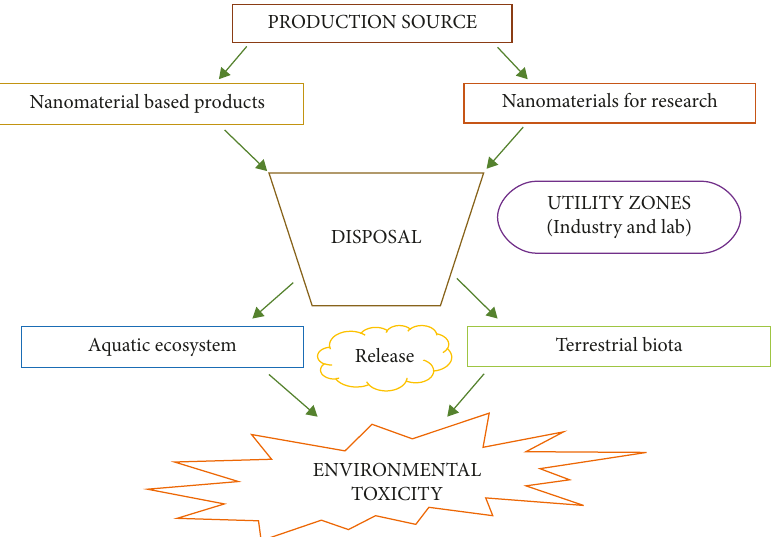
Figure 1: Sourced of nanoparticles and their environmental